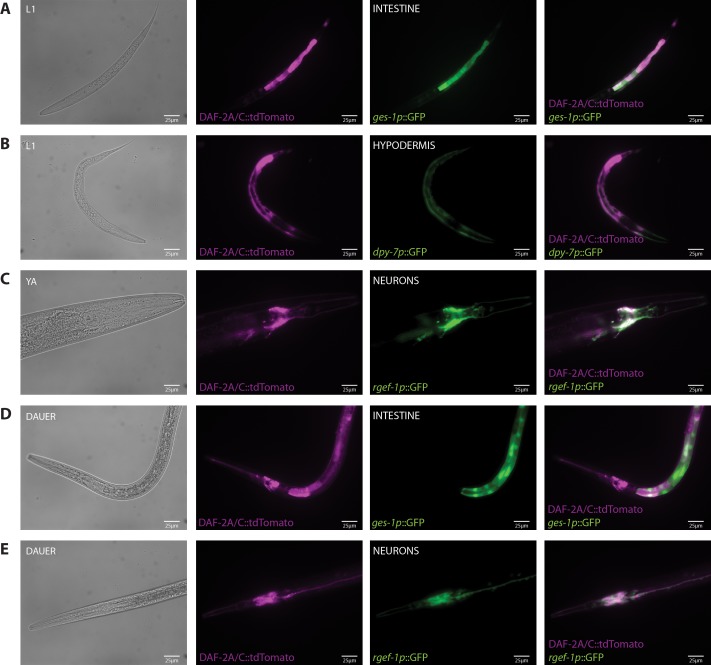
Tissue localization of the DAF-2A/C::tdTomato splicing reporter.(A) Expression of DAF-2A/C::tdTomato with ges-1p::GFP in the intestine in an L1 animal. (B) Expression of DAF-2A/C::tdTomato with dpy-7p::GFP in the hypodermis in an L1 animal. (C) Expression of DAF-2A/C::tdTomato with rgef-1p::GFP in neurons in a young adult animal. (D) Expression of DAF-2A/C::tdTomato with ges-1p::GFP in the intestine in a dauer. (E) Expression of DAF-2A/C::tdTomato with rgef-1p::GFP in neurons in a dauer.